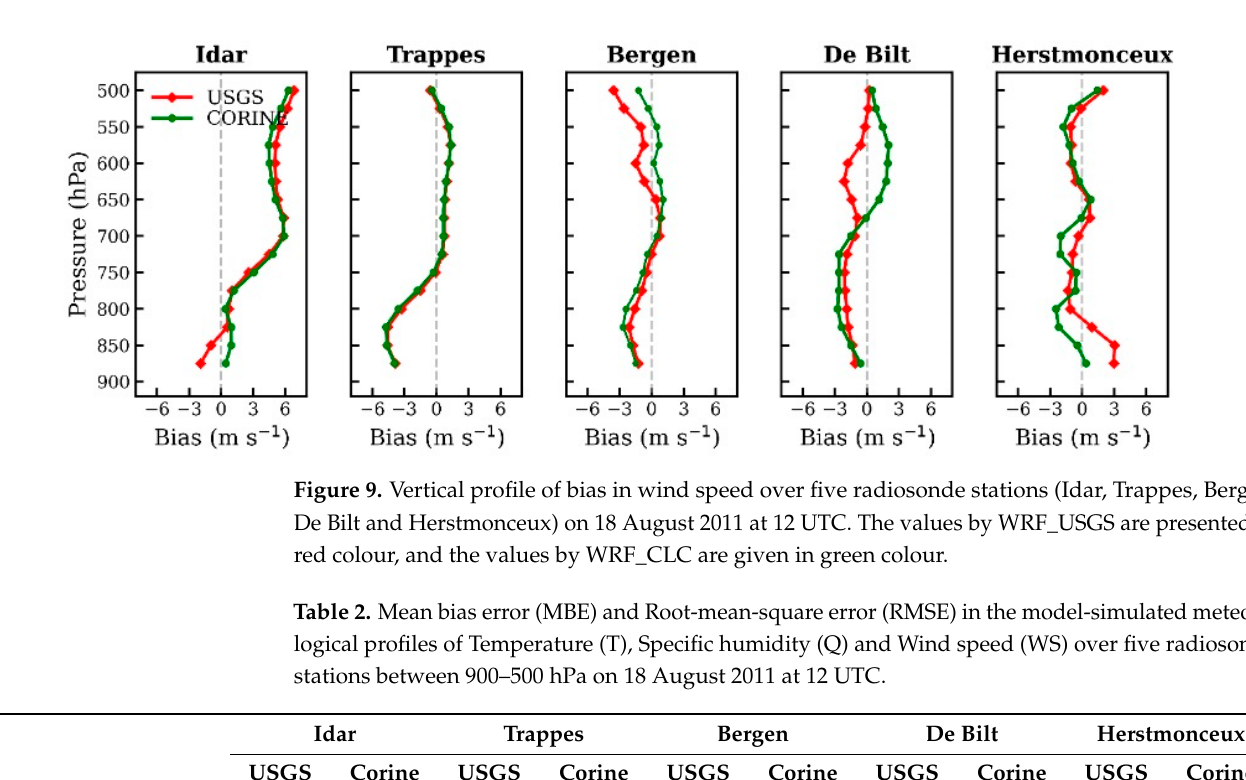
Figure 8. Vertical profile of bias in specific humidity (Q) over five radiosonde stations (Idar, Trappes, Bergen, De Bilt and Herstmonceux) on 18 August 2011 at 12 UTC. The values by WRF_USGS are presented in red colour, and the values by WRF_CLC are given in green colour.